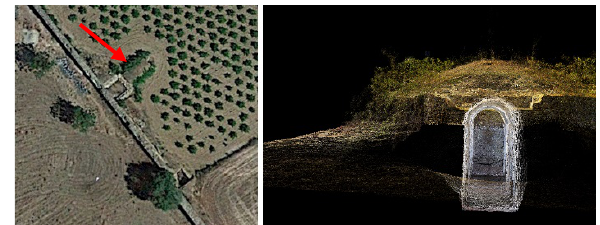
Figure 2. Area of Roman Dam captured with TLS (left), red arrow indicating location of subterranean structure; front view, point cloud render of subterranean structure (right)